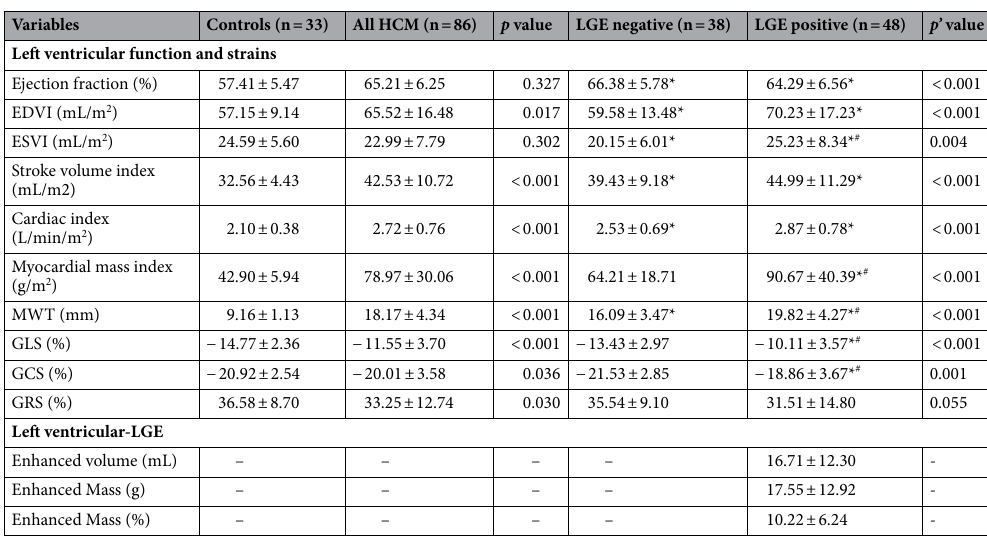
Table 2. CMR parameters of the study population. Values expressed as n (%) or mean ± SD. The p and p’ values reflect comparisons between 2 groups (controls. Vs. total) and 3 subgroups (controls. Vs. LGE (−). Vs. LGE (+)), respectively. CMR, cardiovascular magnetic resonance; LGE, late gadolinium enhancement; EDVI, end-diastolic volume index; ESVI, end-systolic volume index; MWT, maximum wall thickness; GLS, global longitudinal strain; GCS, global circumferential strain; GRS global radial strain. * < 0.05 vs. controls. # < 0.05 vs. LGE